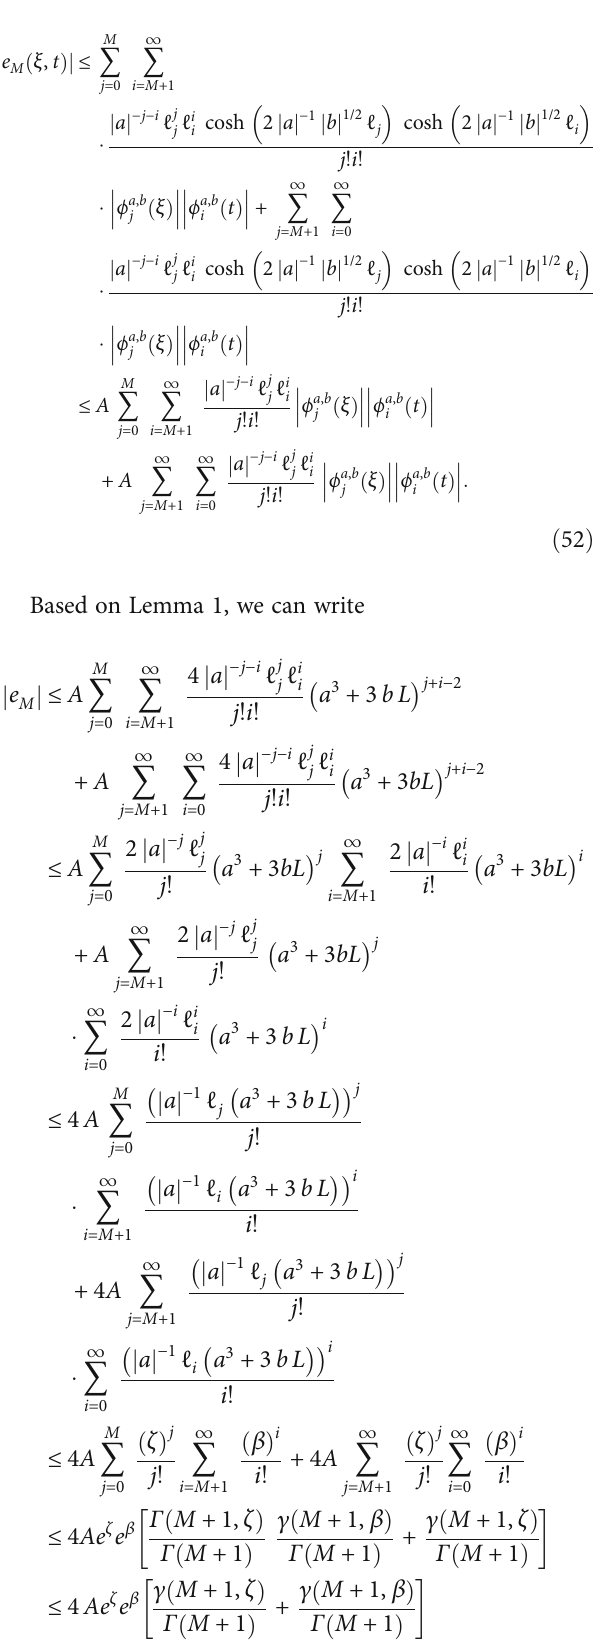
Table 1, the maximum absolute errors ( MAEs ) obtained